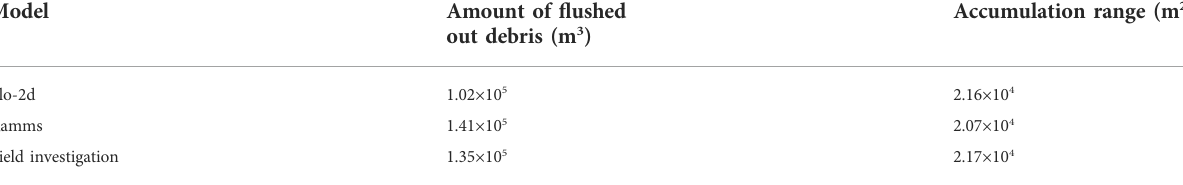
TABLE 1 Validation results for the RAMMS software debris fl ow simulation method.